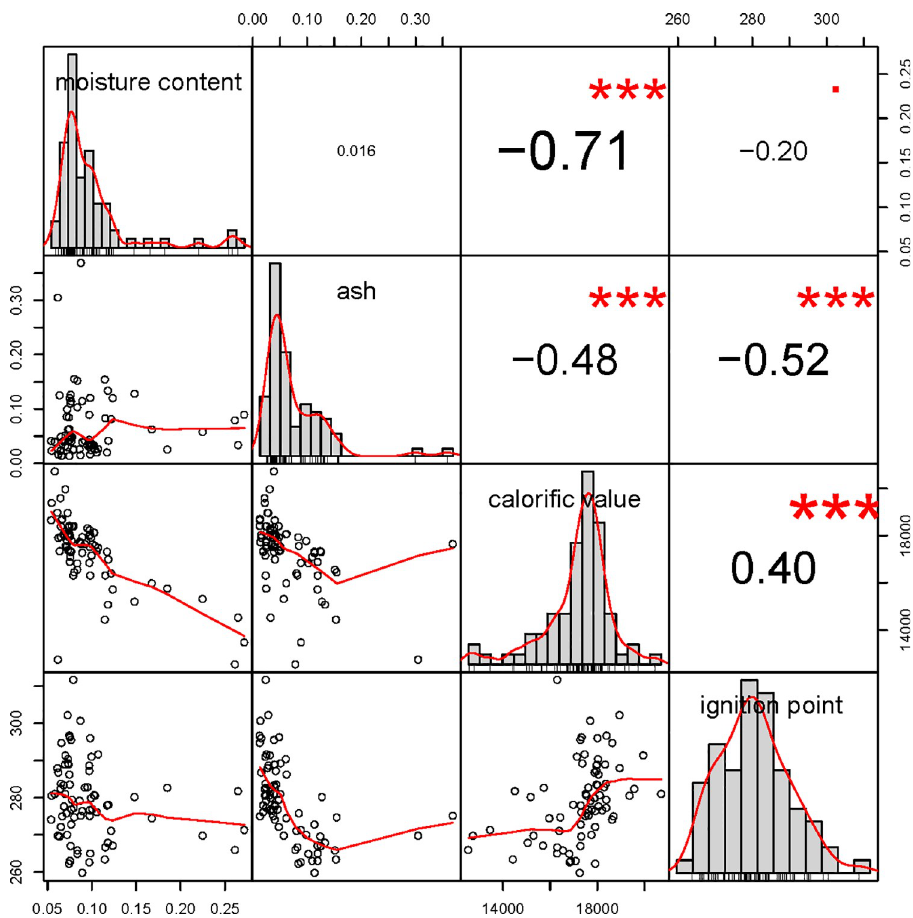
Fig 3. Correlation analysis of each